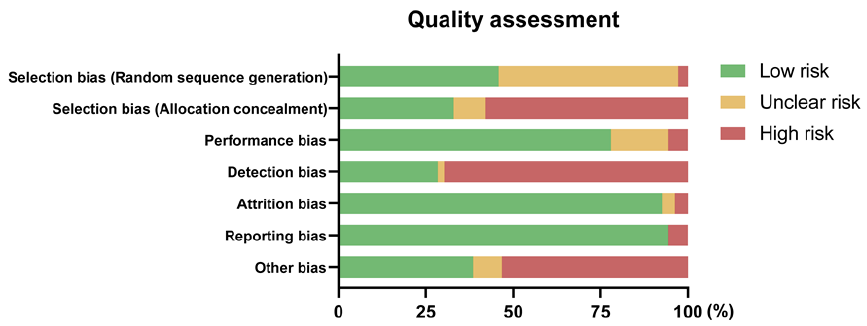
Figure 3. Methodological quality graph: The risk of bias for each item is expressed by percentage.